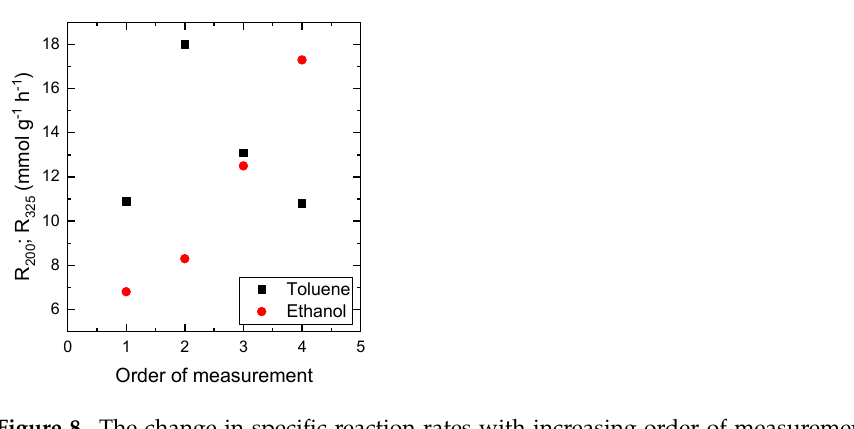
Figure 8. The change in specific reaction rates with increasing order of measurement. Reaction conditions for the NiCo11 15 catalyst: ca. 3.8 g of sputtered catalysts; 760 ppm of ethanol or 780 ppm of toluene; GHSV 21 L g cat−l h −l ; temperature ramp: 2 °C min −l . The deconvolution of the O 1s line of the XPS spectra of the catalysts